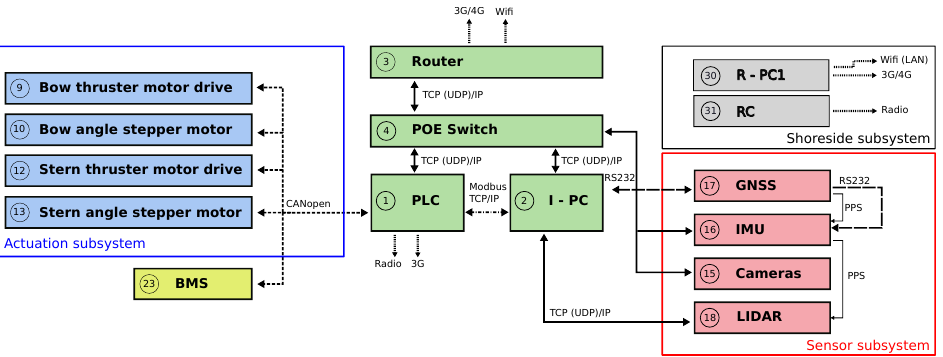
Figure 3. Main USV system components and their communication links, adapted from [5] with permission from Elsevier,